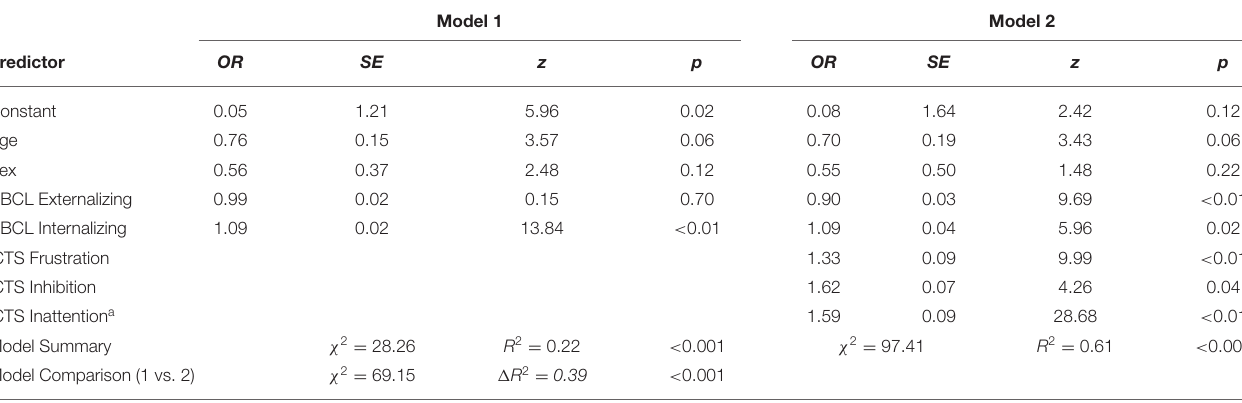
TABLE 7 | Summary of a multivariate binary logistic regression analysis predicting clinical treatment from ICTS and CBCL-broadband scales.